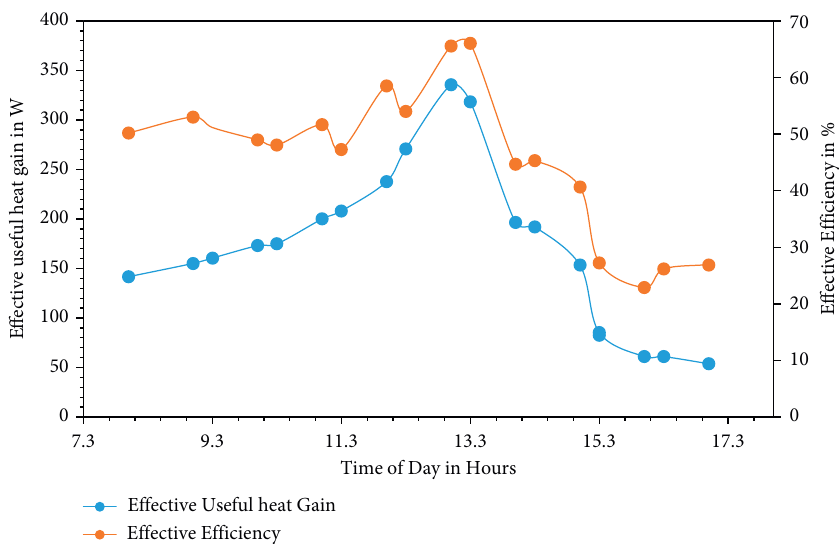
Figure 8: Hourly variations of efective useful heat gain and efective efciency of the SAH with inverted bafe plate.